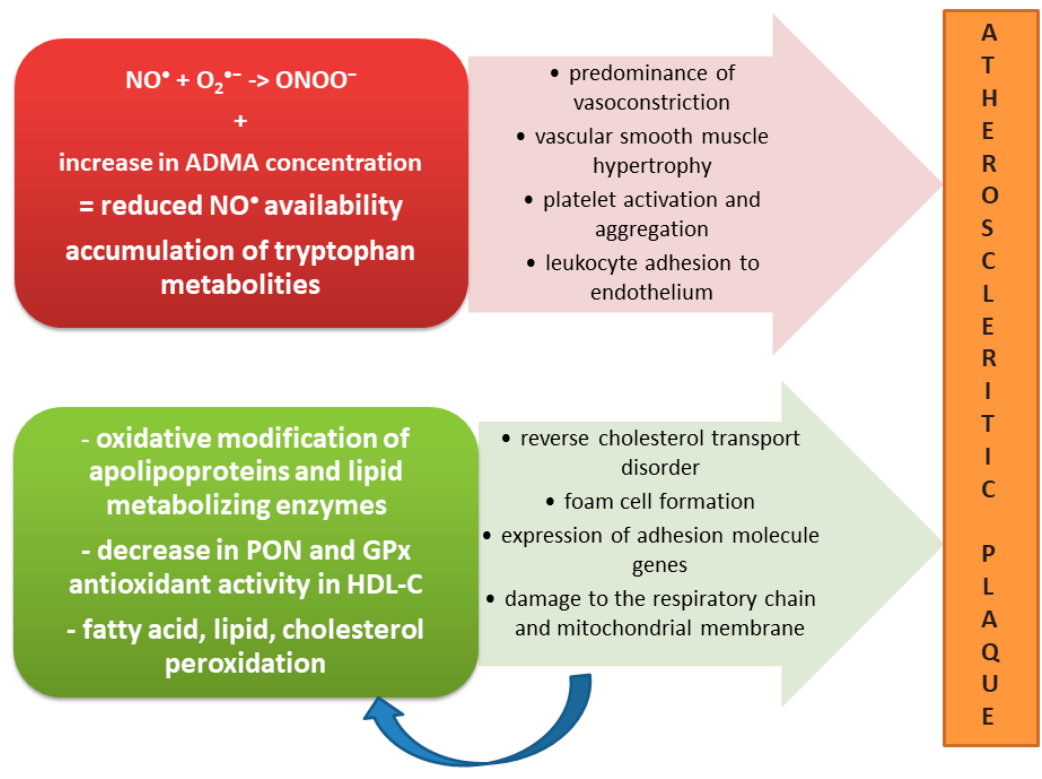
Figure 3. The influence of oxidative stress on the development of atherosclerotic changes in